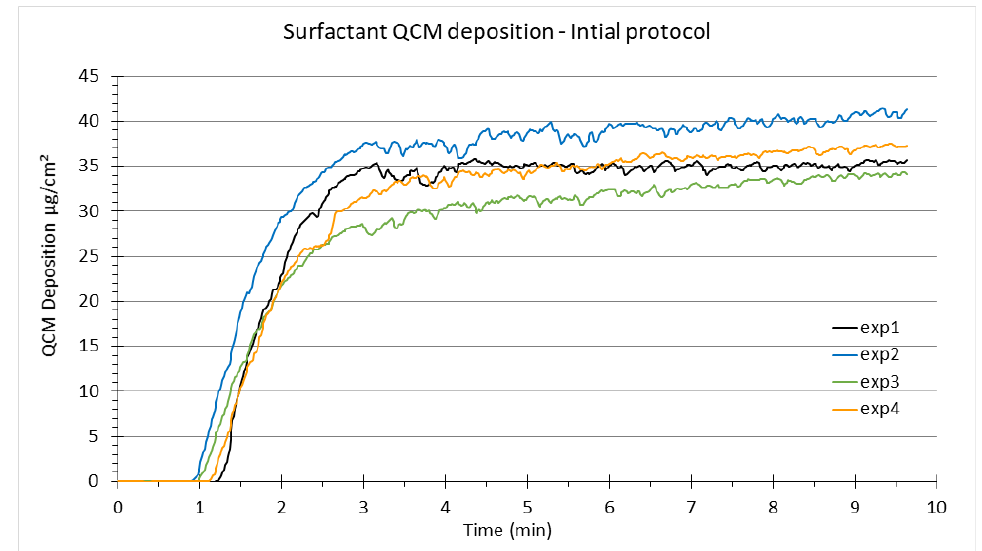
Figure 2. QCM curves showing the cloud deposition of surfactant (qualitatively) in the VITROCELL ® Cloud System. This Figure illustrates the reproducibility of the QCM response for independent